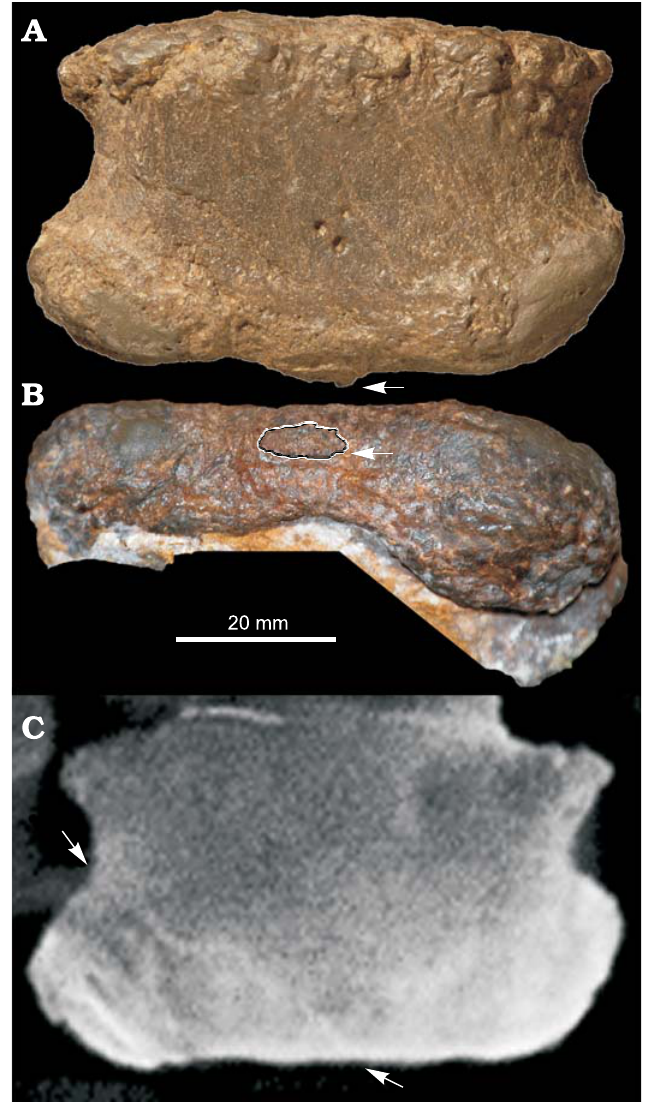
Fig. 8. Overgrowth type 3 (arrows in A, B) on the distal articular surface of the left manual phalanx IV-1 of the camarasaurid sauropod SMA 0002 from Upper Jurassic Morrison Formation, Howe-Stephens Quarry, Wyoming, USA; in anterior/dorsal ( A ) and distal ( B ) views, and CT scan of fron- tal slice ( C ), note the probable healed fracture (arrows). Photos taken by Rosemarie Roth (University of Zurich, Switzerland).